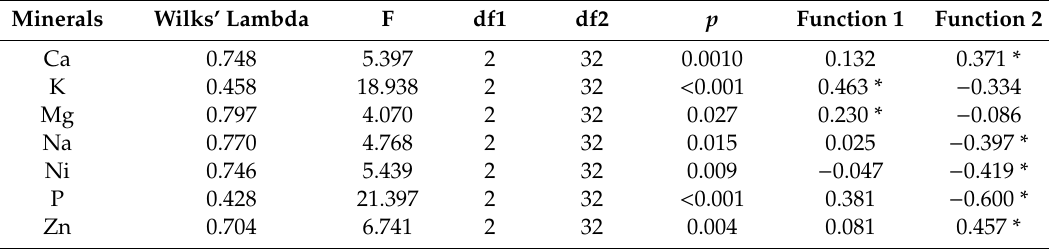
Table 3. Contribution of minerals to the canonical discriminant function structure